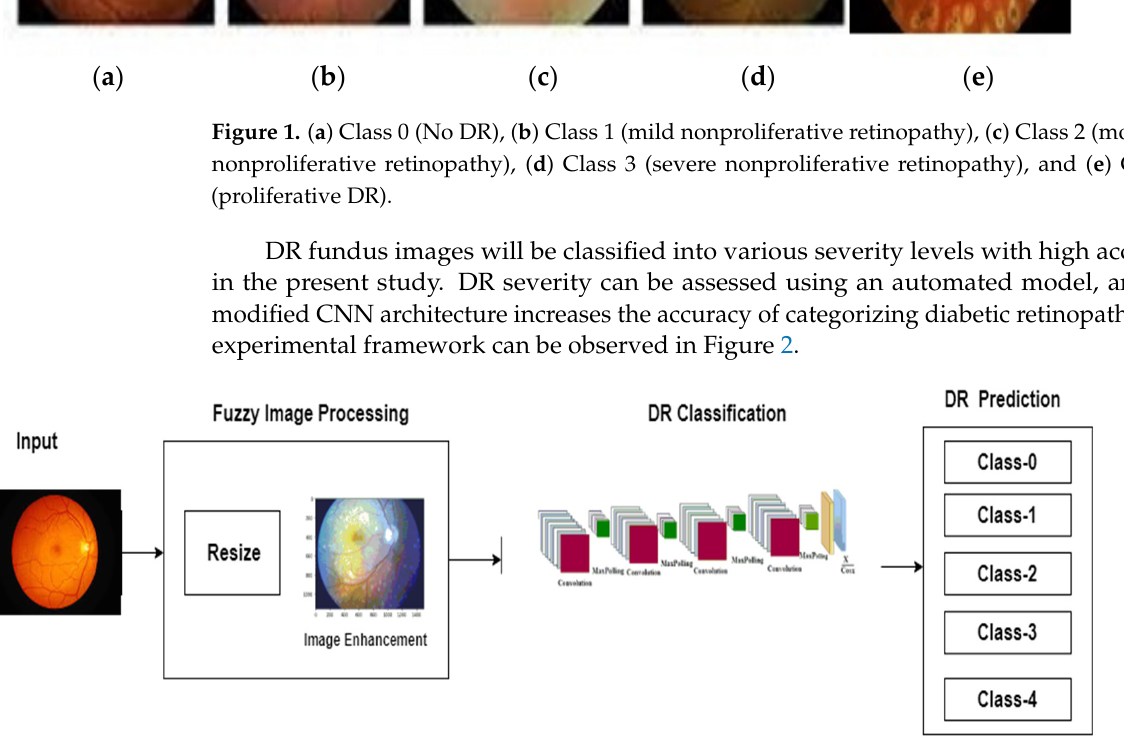
Figure 2. Experimental framework.